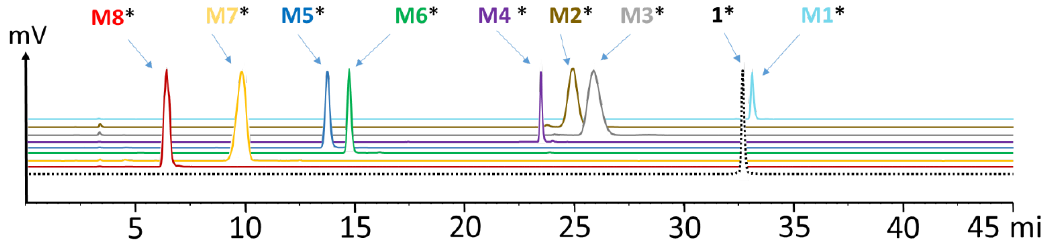
Figure 2. Radio-HPLC chromatograms of [ 177 Lu]Lu- 1 and its 177 Lu-labeled metabolites M1 – M8 (* indicating radiolabeled with lutetium-177).